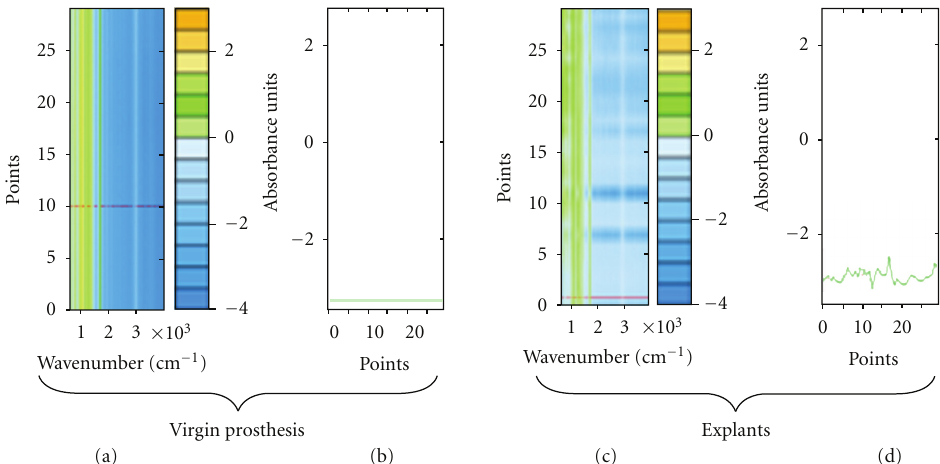
Figure 10: Qualitative analyses using infrared spectroscopy: x -axis represents the wave number and y -axis represents the spectrum number.